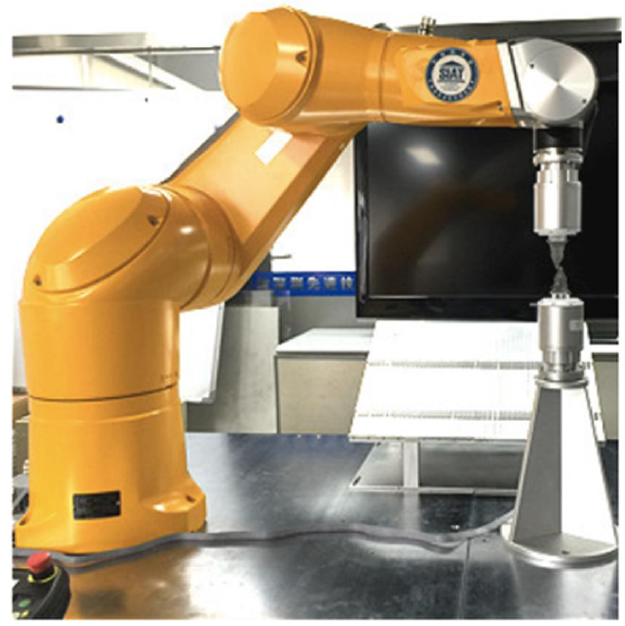
Figure 5. Novel robot system for orthodontic archwire bending [38] .